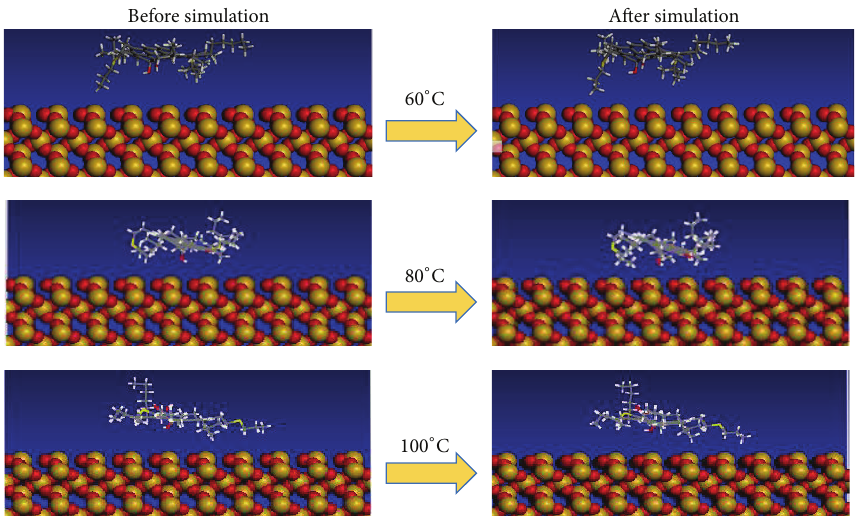
Figure 9: The interface configuration of asphaltene/SiO 2 (60–100 ∘ C).